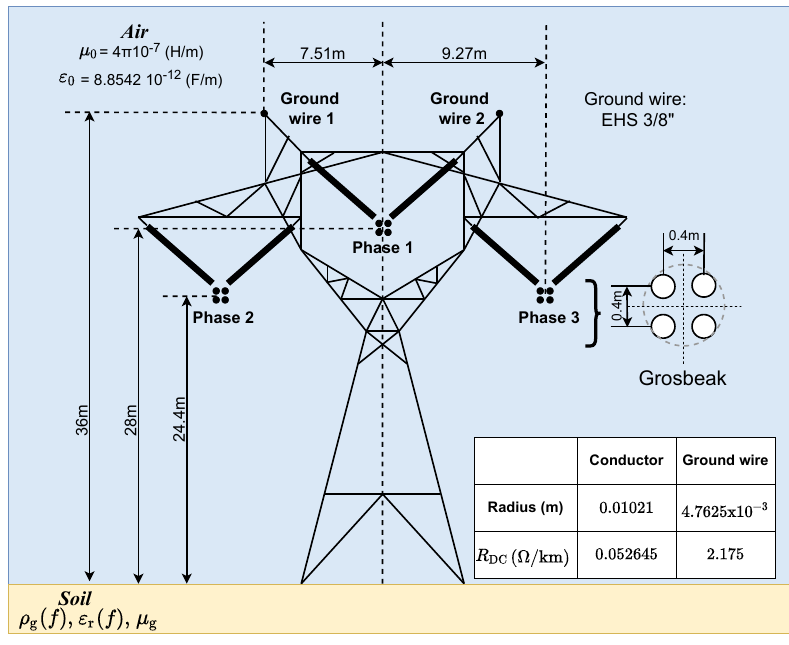
Figure 6. Configuration of the 440-kV OHTL with vertical symmetry